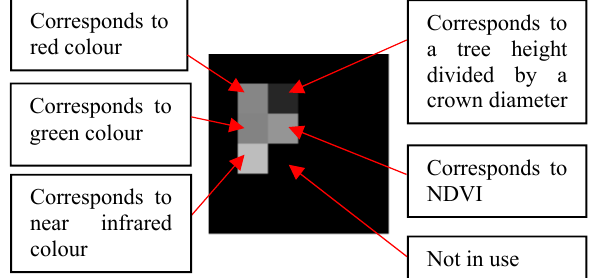
Figure 4. The areas of a feature image corresponds to selected feature elements.